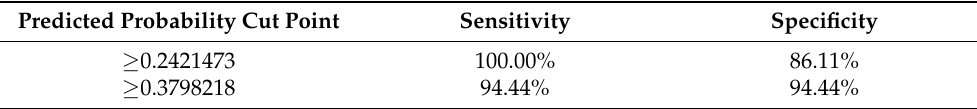
Figure 6. Sensitivity and specificity plot of the final model with the outcome Stage 1 EC patients vs. controls. Table 7. Final Stage 1 EC patients vs. controls model: sensitivity/specificity plot for the resulting multivariate logistic regression model for sensitivity levels higher than specificity